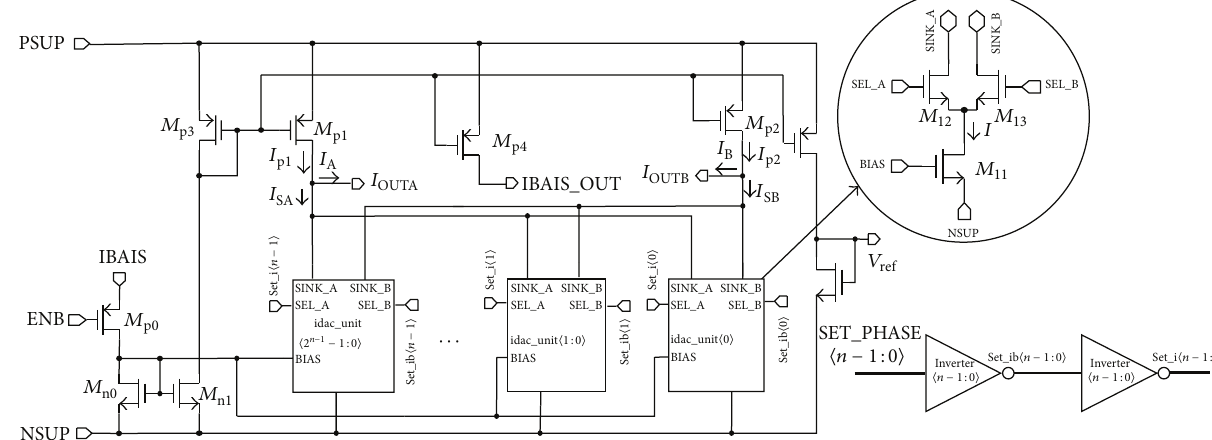
Figure 4: Structure of the programming current output